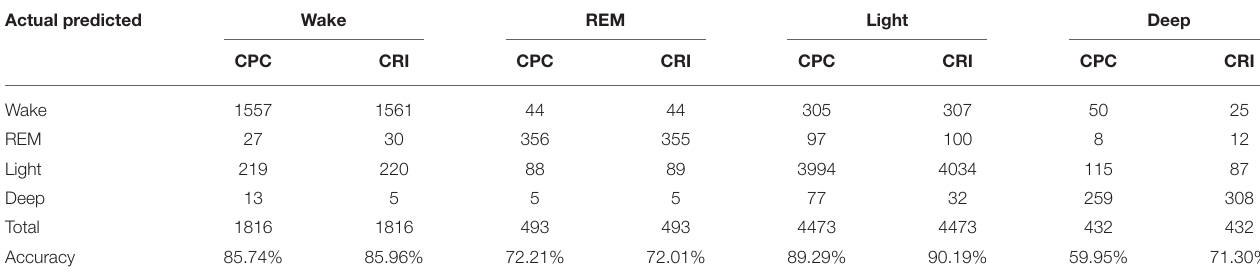
TABLE 6 | Confusion matrix of sleep stage classification using CPC and